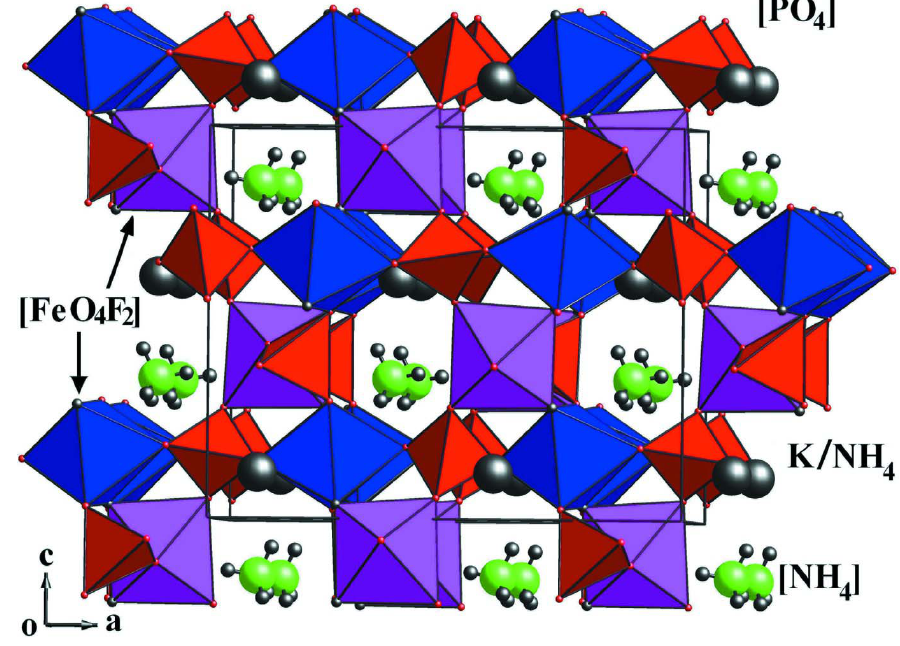
Figure 1 Unit cell of (NH octahedra; PO